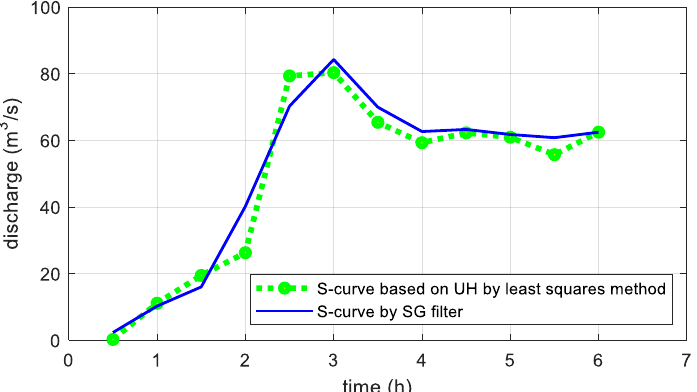
Figure 7. Comparison of S-curves before and after the application of the SG filter (in Shaol Creek watershed).